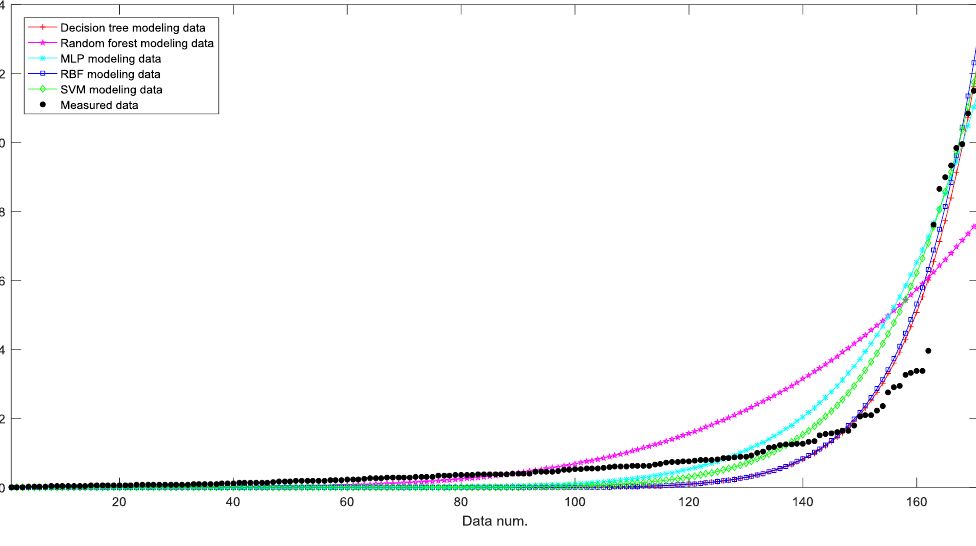
Figure 12. Comparison of different methods for prediction of permeability (black dots are measured